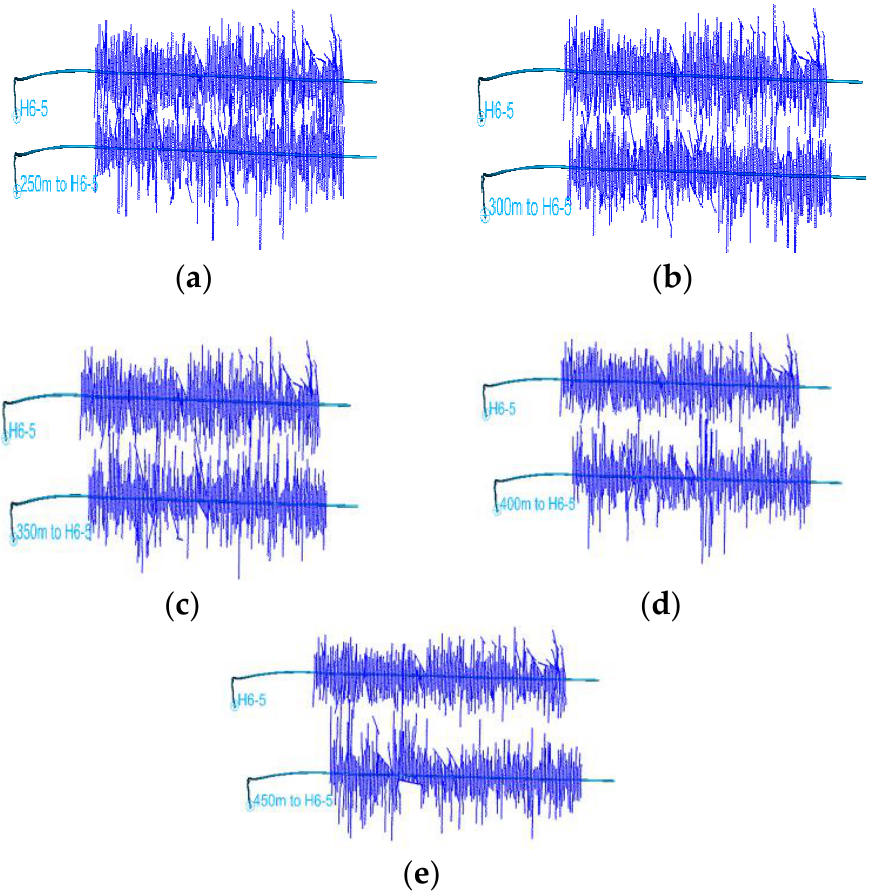
Figure 11. The fracture conditions under different well spacing: ( a ) 250 m; ( b ) 300 m; ( c ) 350 m; ( d ) 400 m; ( e ) 450 m.